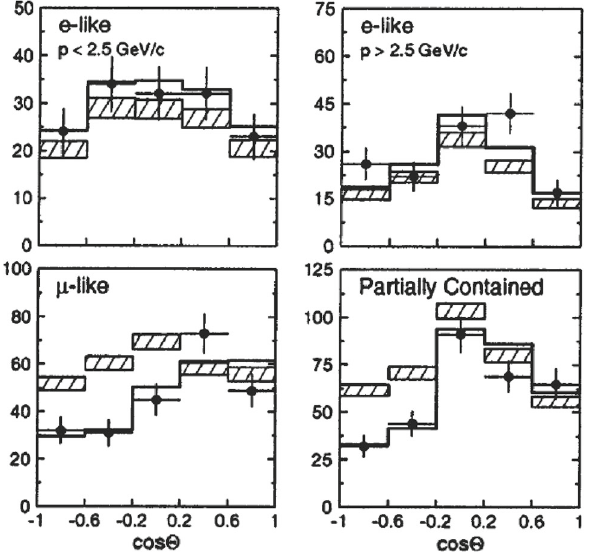
Fig. 4 Zenith angle distribution of the multi-GeV FC e-like, FC μ -like and the partially contained events from 535 days of Super-K data (33.0 kt year) [34]. The vertical axis shows the number of events. The hatched datashowstheeventspredictedwithouttheoscillation.Thefittedlinefor the best oscillation parameters are also shown. A clear deficit of upward going events (cos θ ∼ − 1) in FC μ -like and partially contained events is seen. This is the evidence of the atmospheric neutrino